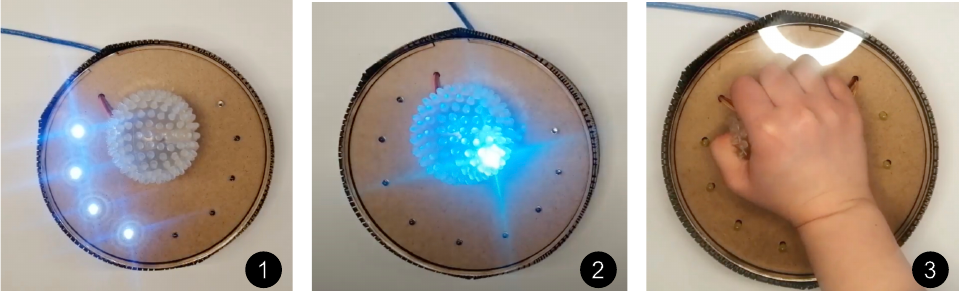
Figure 7. Remolight technical prototype ( 1 . indicated timer with LED bar; 2 . show notifications with light shining in the ball; 3 . squeeze the ball to seek help or knock it to send an agreement message to other